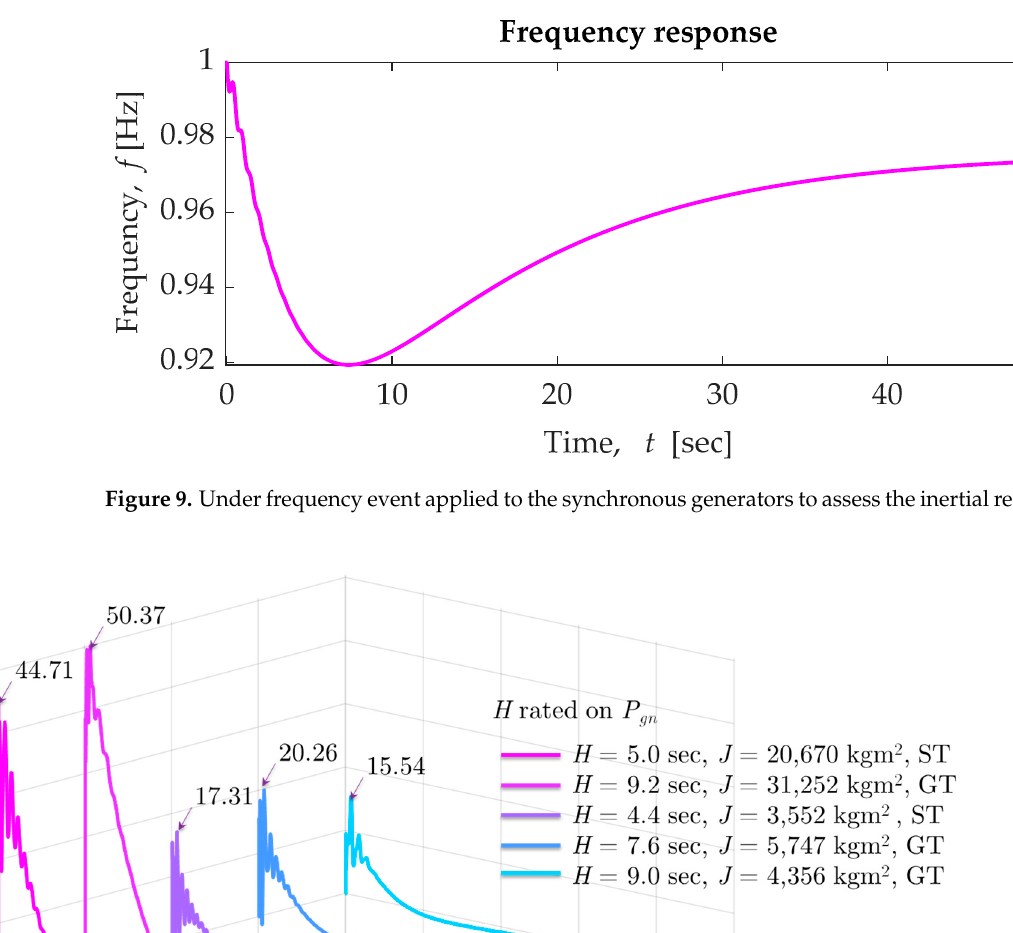
Figure 9. Under frequency event applied to the synchronous generators to assess the inertial response. Five different synchronous generators are considered in the assessment, two of them